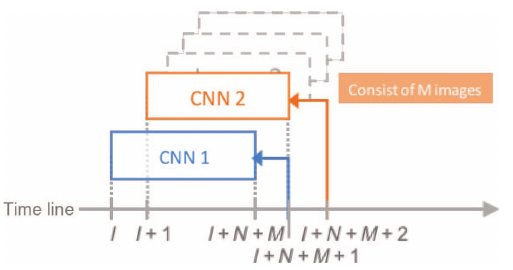
Figure 4: Process of Combining the Moving Windows into the Convolution Model in Workflow